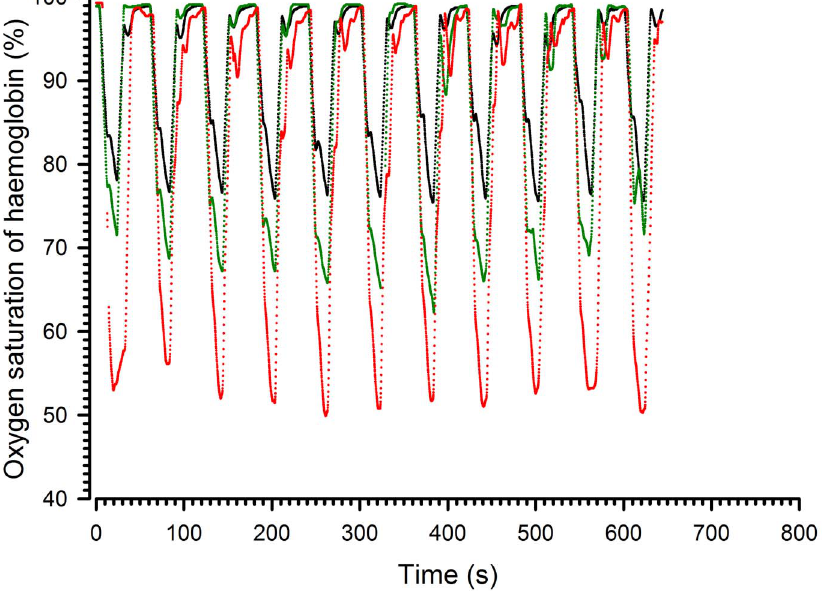
Figure 8. Representative records of haemoglobin oxygen saturation during chronic hypoxia-reoxygenation. Cycles alternated 15 s of hypoxia – 45 s of normoxia. The black line corresponds to a hypoxic FIO 2 of 12%, the green line to a FIO 2 of 9% and the red line to an FIO 2 of 6%.